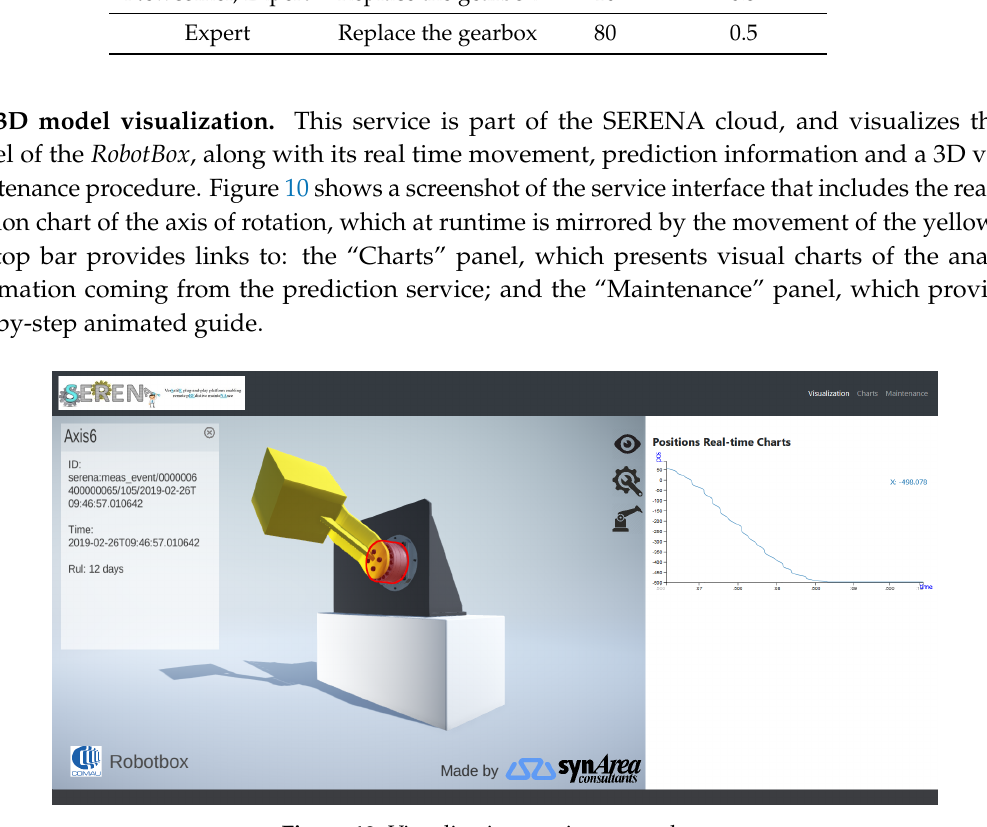
Figure 10. Visualization service